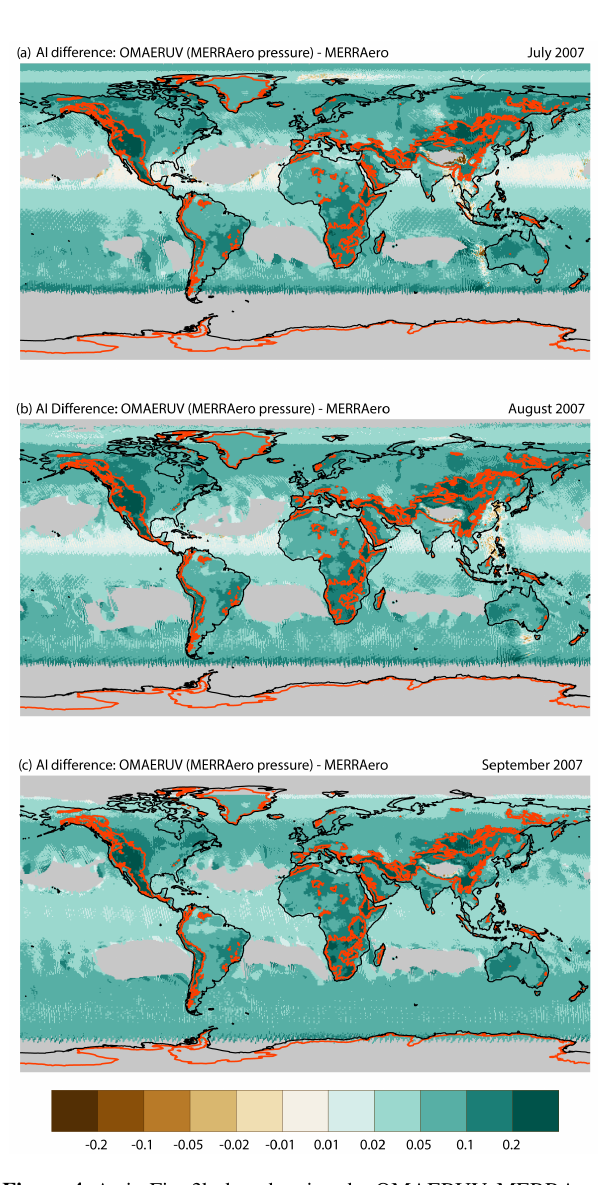
Figure 4. As in Fig. 3b, but showing the OMAERUV–MERRAero AI difference for OMAERUV using the MERRAero surface pres- sure for (a) July, (b) August, and (c) September 2007. Again, the red line is the 1000m topographic height